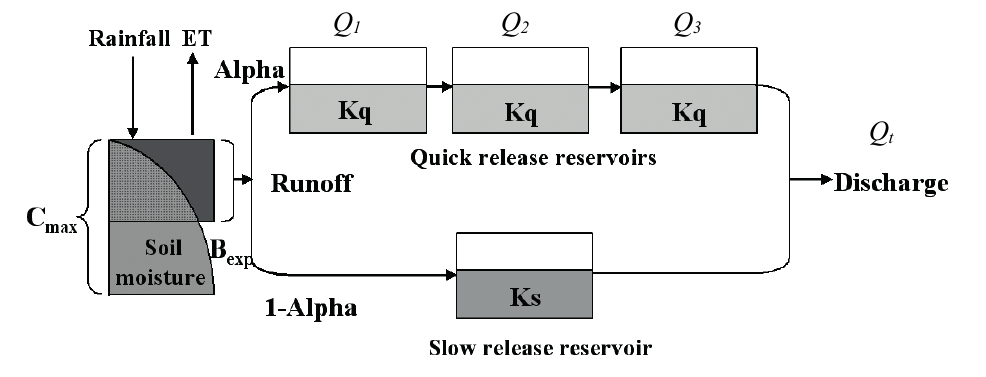
Fig. 1 The schematic description of